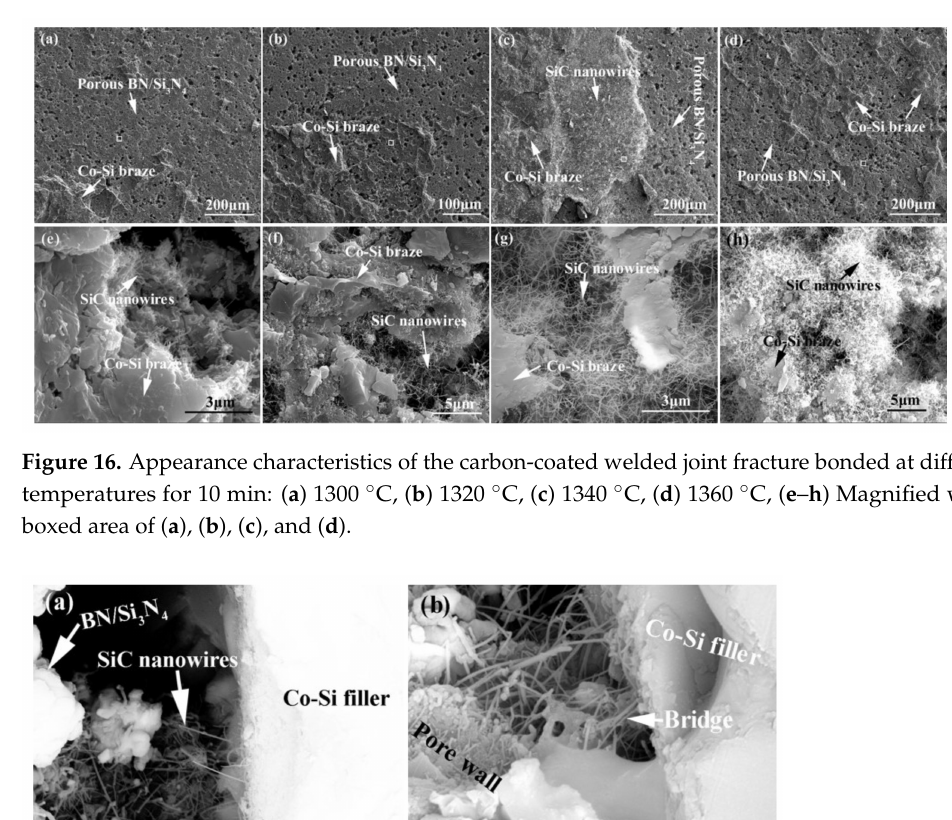
Figure 15. The temperatures impact on the carbon-coated welded joint strength bonded with the SiCo38 alloy for 10 min.